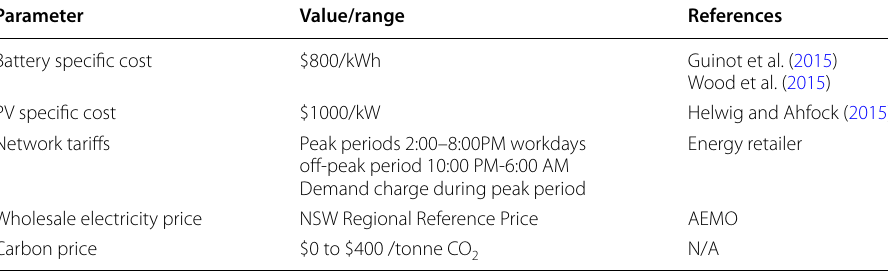
Table 2 Case study electricity, capital, and carbon costs